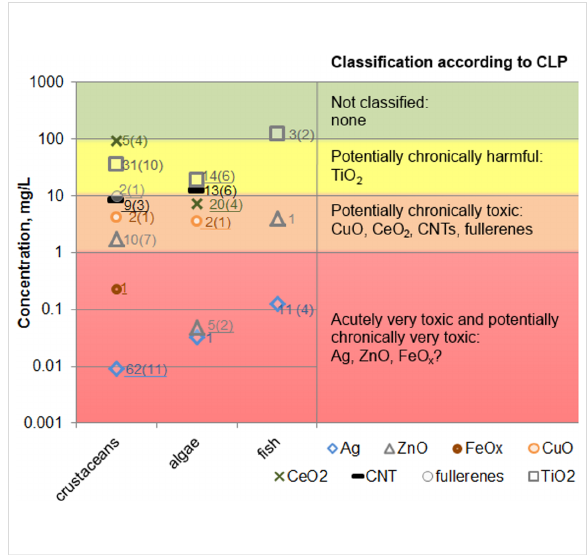
Figure 7: Classification of selected nanoparticles according to Euro- pean Union CLP legislation based on their toxicity to fish (96 h), daph- nids (48 h) and algae (72 or 96 h). Toxicity values were extracted from Figure 6. Classification of NPs is based on the most sensitive organism as described in CLP [57]. The number next to the symbol indicates the number of E(L,I)C 50 values used to derive the median value and the number in the parenthesis indicates the number of papers from which the respective data originates. Underlined numbers indicate the datapoints (lowest E(L,I)C 50 value for this ENM) used for classification. Note the logarithmic scale of the